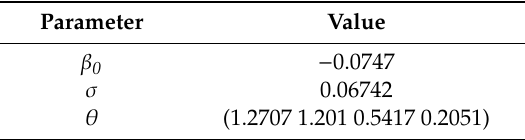
Table 2. The Kriging model parameters.